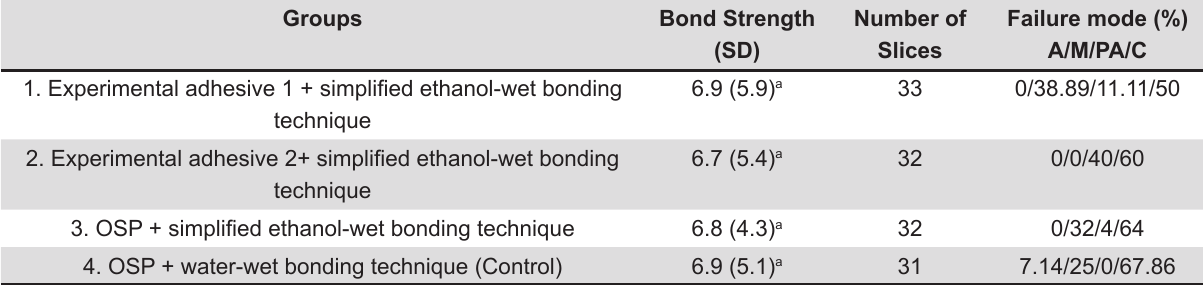
Table 1- Median push-out bond strength values* (SD) expressed in MPa, number of specimens (N), and percentage of failure mode distribution recorded in the experimental groups. OSP= One-Step